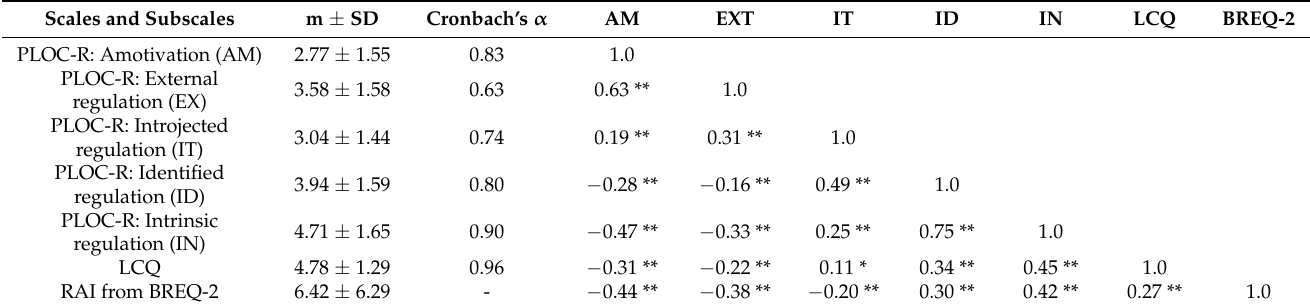
Table 2. Correlations between the Revised Perceived Locus of Causality in Physical Education Scale (PLOC-R) subscales, Behavioral Regulation Exercise Questionnaire 2 (BREQ-2) and Learning Climate Questionnaire (LCQ).